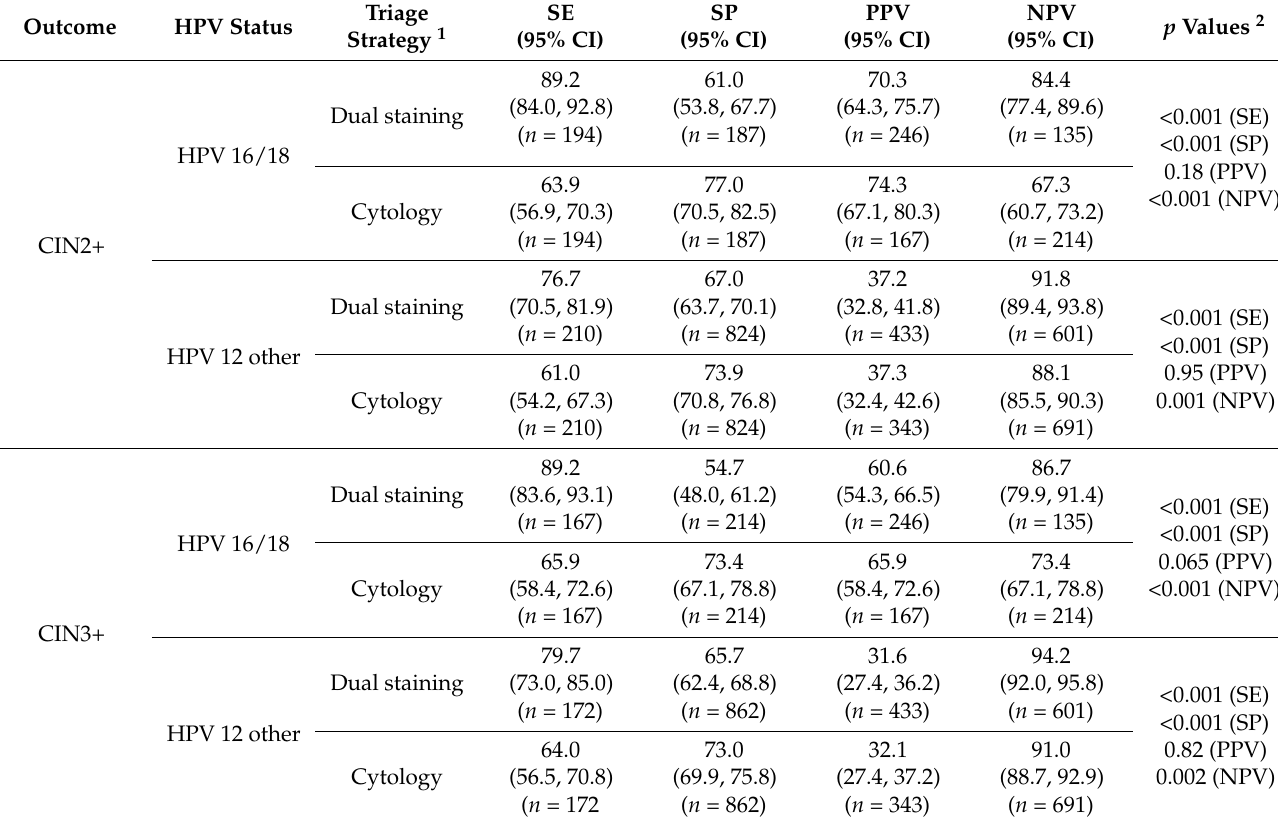
Table 3. Performance of p16/Ki-67 dual staining as compared to cytology for triage of CIN2+ and CIN3+ in a cohort of primary high-risk HPV positive women, grouped according to partial